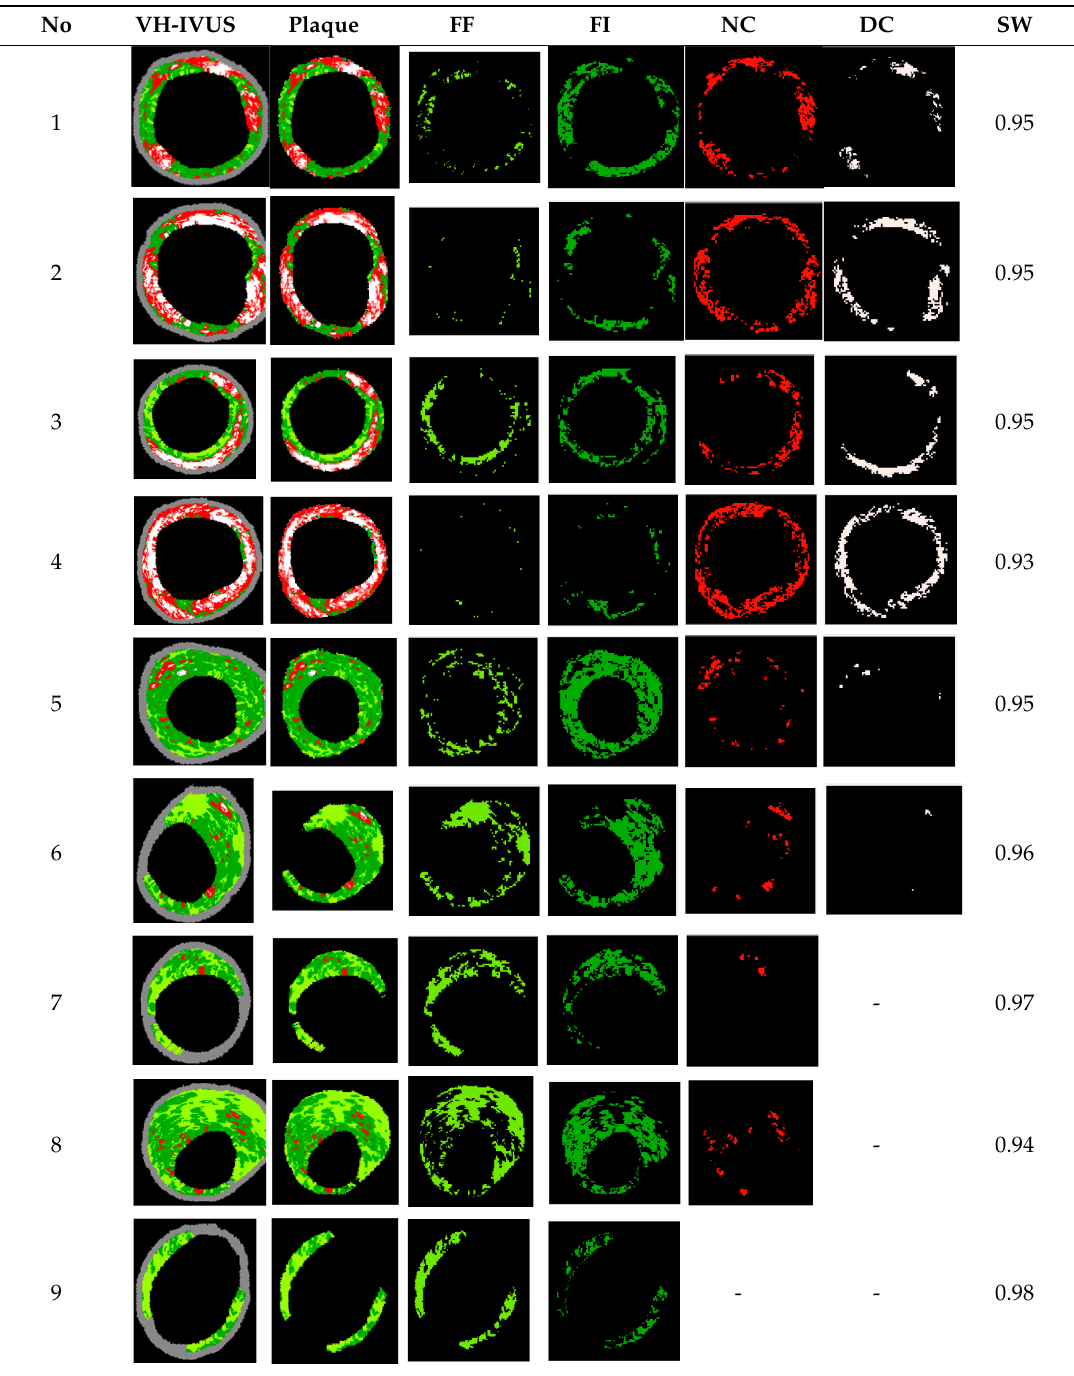
Table 3. Results of VH-IVUS segmentation by KMPSO-mED, (SW: Silhouette